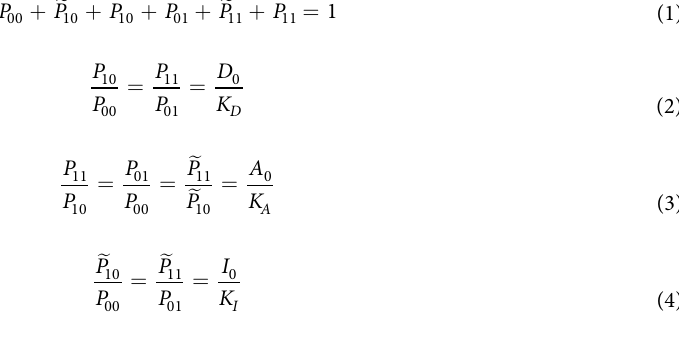
Figure 6. Model of the competitive inhibition of AtSOT18 by PAP. In equilibrium, six different populations of enzyme • ligand complexes are present with their respective probabilities P ij , where i and j represent the status of the donor and acceptor site, respectively. 0 and 1 represent non-occupied and occupied enzyme sites.  P represents the probability of an enzyme • inhibitor complex species with the inhibitor bound to the donor site. D 0 , A 0 , and I 0 represent the initial concentration of donor PAPS, acceptor ds-3MTP, and inhibitor PAP, respectively. Dissociation constants are displayed as K D for the donor, K A for the acceptor, and K I for